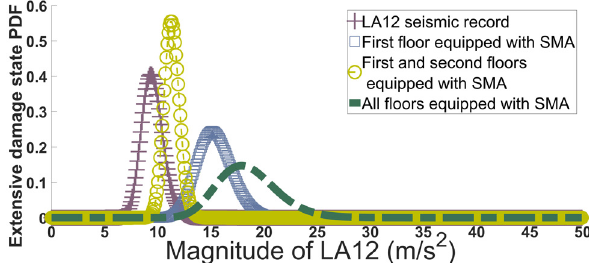
Figure 15: Probability of being in or exceeding extensive damage state for three-story optimized